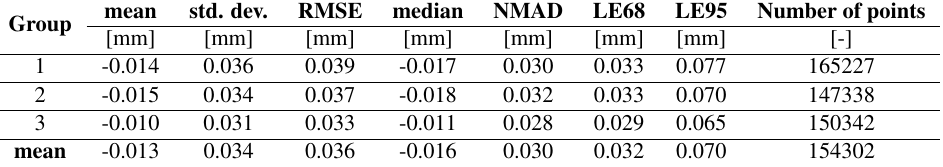
Table 1: Statistical indicators computed for area 1 (side a)